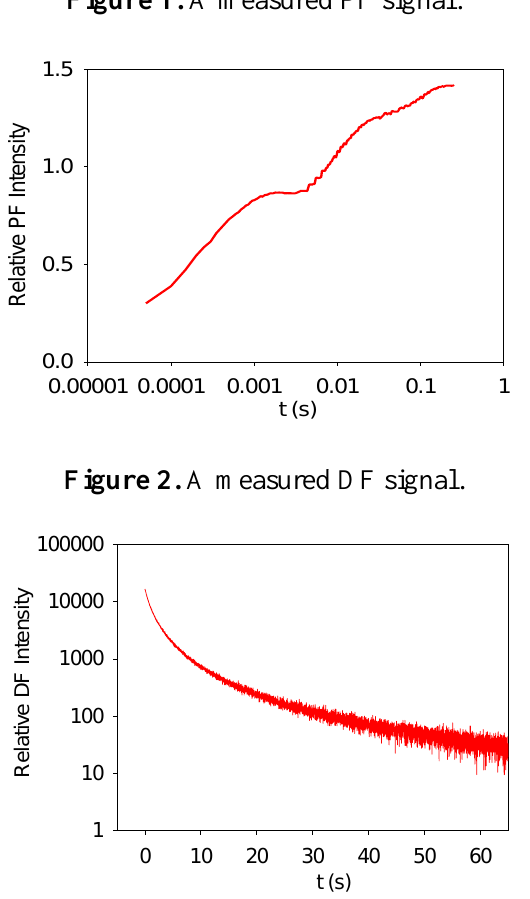
Figure 1. A measured PF signal.